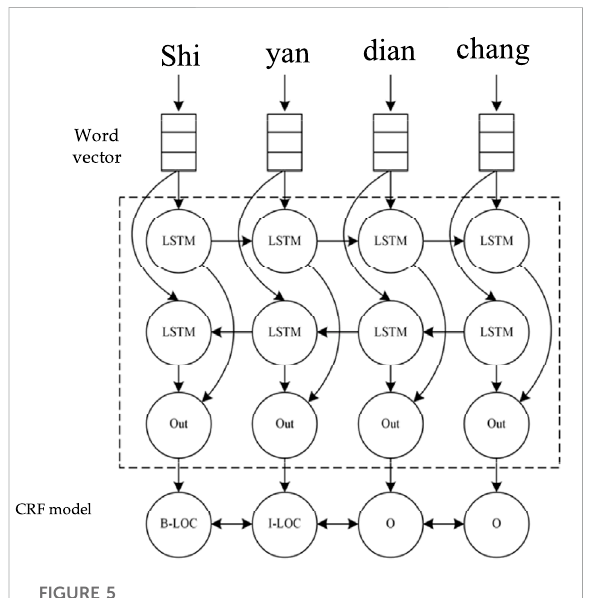
FIGURE 5 Bidirectional LSTM and CRF model for entity recognition.